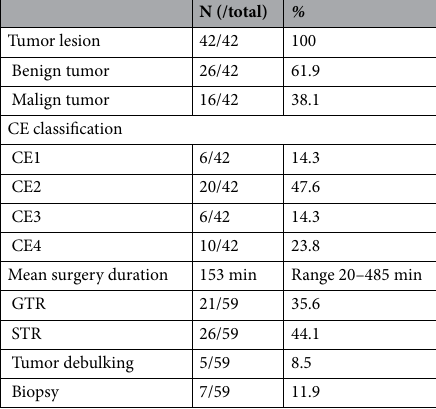
Table 2. Histopathological and surgical data, as well as subgroups according to the implemented CE classification based on extent of the lesions: CE1: Intraosseous lesion, CE2: Destruction of the osseous clival cortical bone, CE3: Brainstem reached without compression or infiltration, CE4: Compression/infiltration of the brainstem.